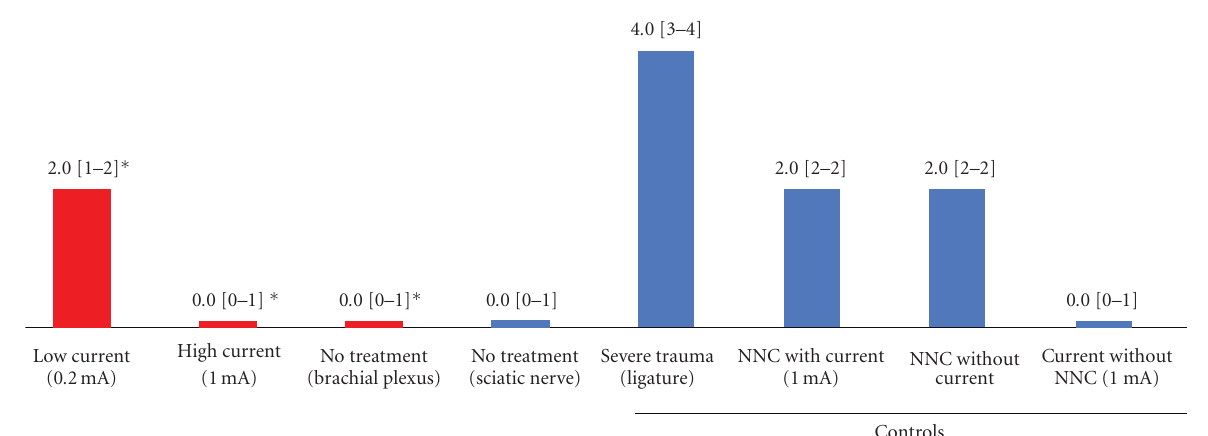
Figure 5: Treatment groups and controls. NNC, Needle-nerve contact; (), interquartile range; ∗ , high current group was compared with low current and none-treatment (brachial plexus) group (Wilcoxon-Mann-Whitney test). The di ff erence of applied nerve injury score values between high and low current treatment was significant ( P < . 01) whereas no significant di ff erence ( P = . 46) was found between the nontreatment group (brachial plexus) and the high current